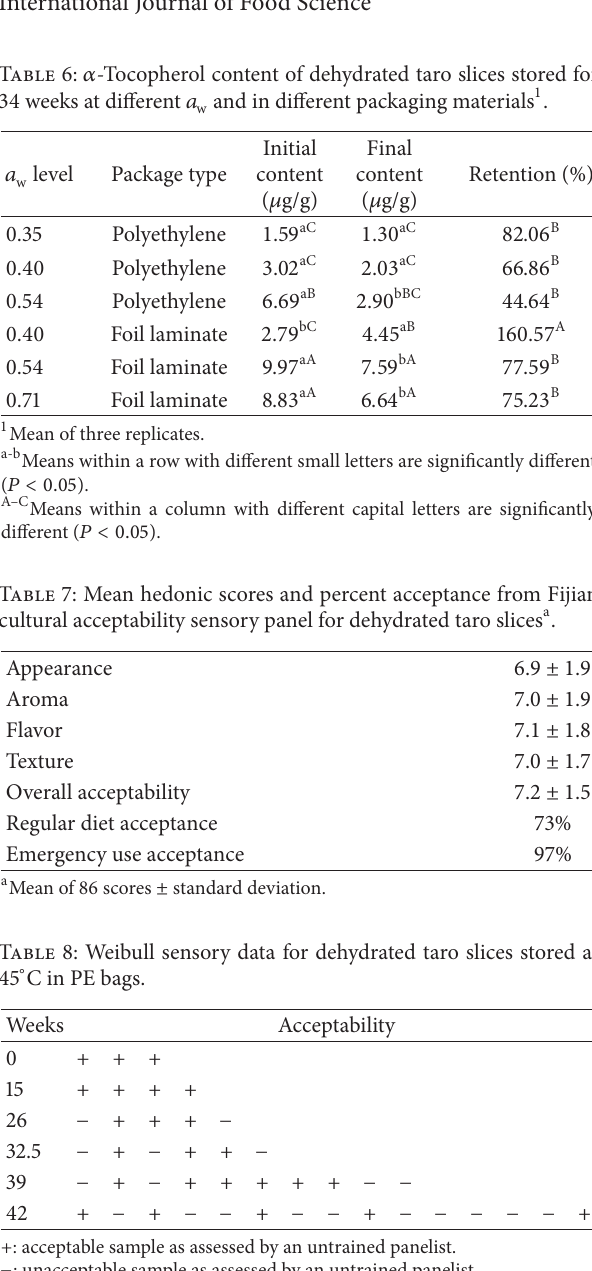
Figure 2: Weibull hazard plot for dehydrated taro slices stored at 45 ∘ C in